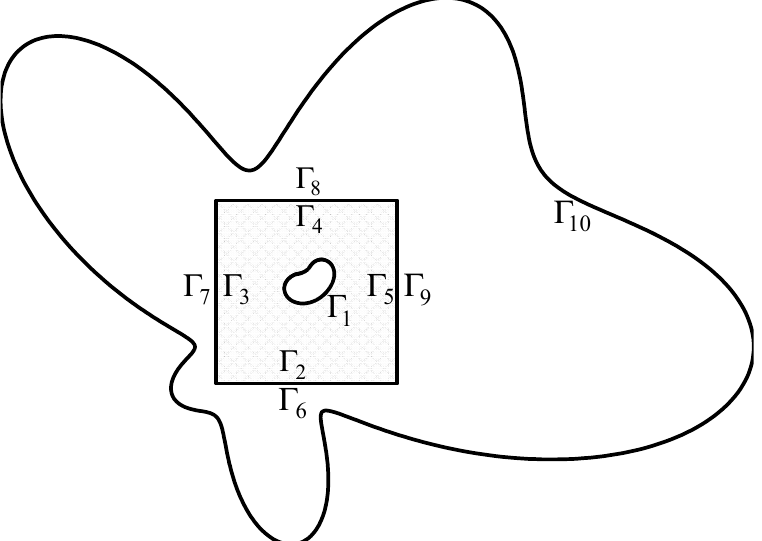
Figure 19. The configuration of the boundary condition.